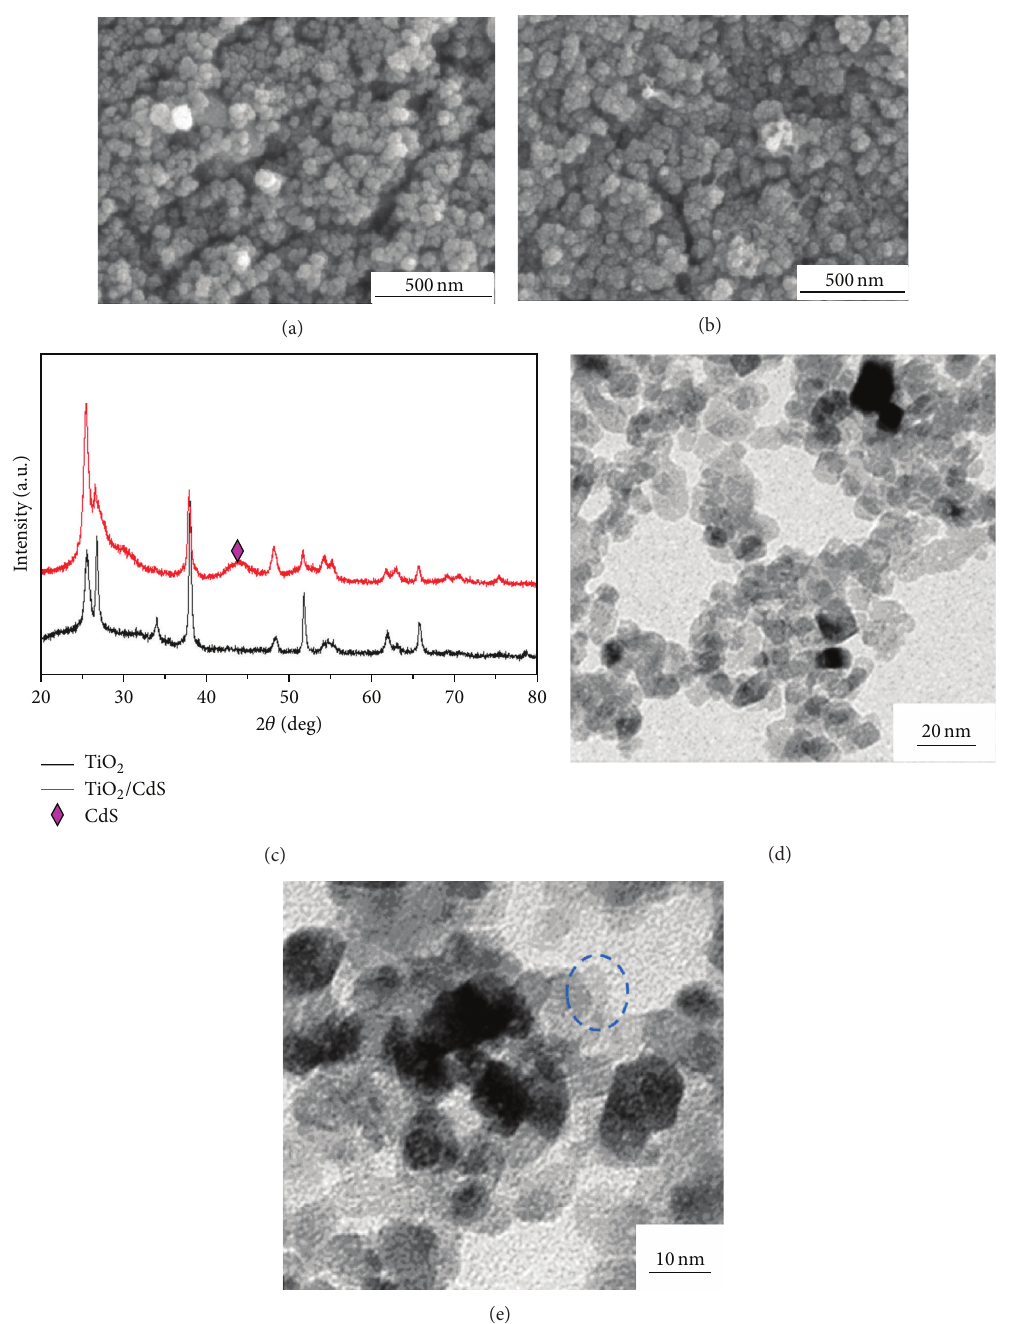
Figure 1: SEM of TiO 2 with different amount of CdS, (a) 4 CBD cycles of CdS, (b) 10 CBD cycles of CdS, (c) typical XRD patterns, and (d) and (e) typical TEM images of the photo